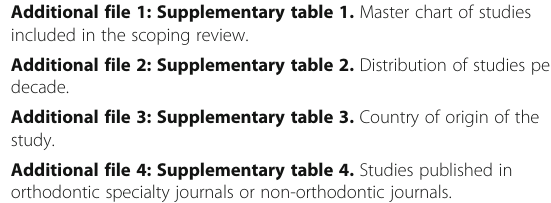
Additional file 2: Supplementary table 2. Distribution of studies per decade. Additional file 3: Supplementary table 3. Country of origin of the